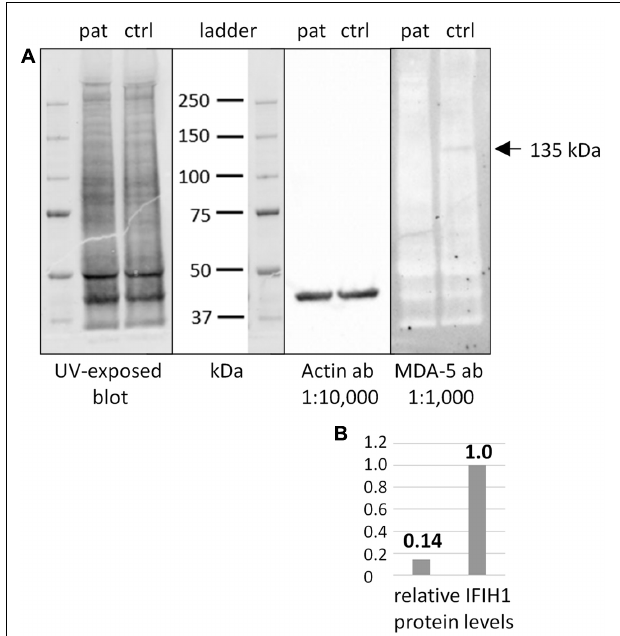
FIGURE 2 | Western blot of IFIH1 using the rabbit monoclonal antibody MDA-5 (D74E4). (A) The protein extract from cultured fibroblasts of a healthy control proband (ctrl) yielded a specific band of endogenous IFIH1 at the expected size of 135 kDa. (B) The 135 kDa band was reduced to background level (ratio of 1:0.14) in the protein sample from cultured fibroblasts of the patient (pat) indicating the absence of wild type IFIH1. The blot was rehybridized with an anti-actin antibody to adjust signal volumes for equal protein loading between control and patient. According to the manufacturer, MDA-5 mAb recognizes the residues surrounding p.Arg470 of human MDA5 (IFIH1) protein.